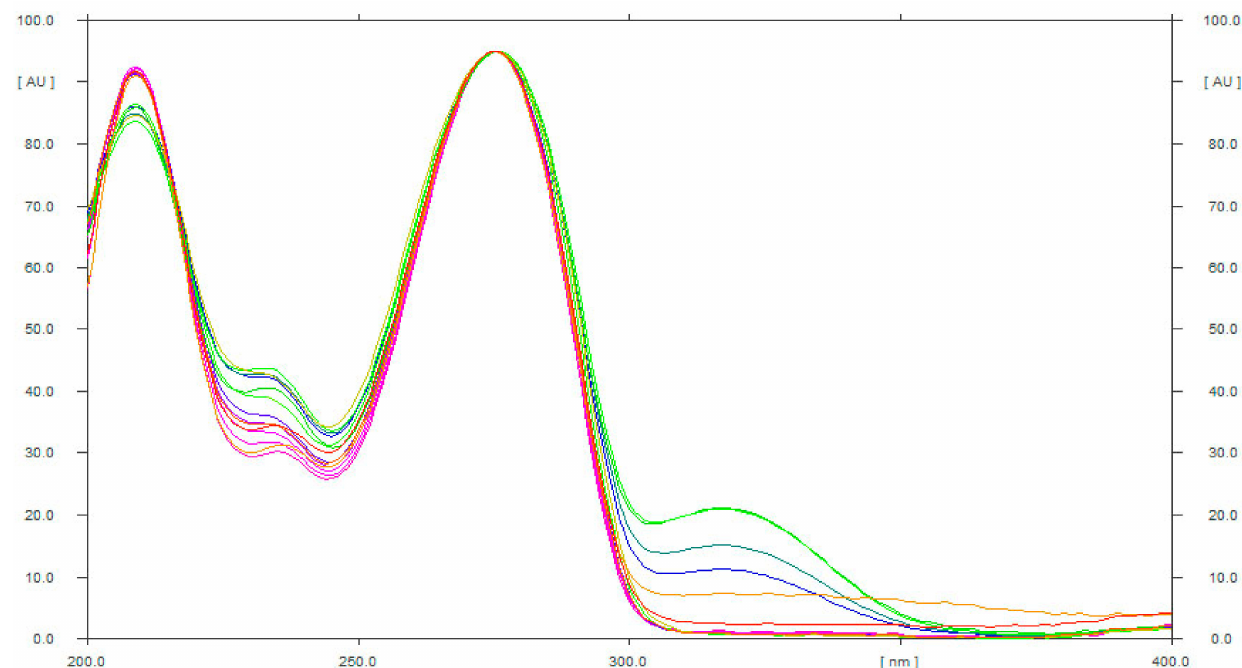
Figure 3. UV absorption spectra of standard caffeine, different ED, and various commercial formula- tions,